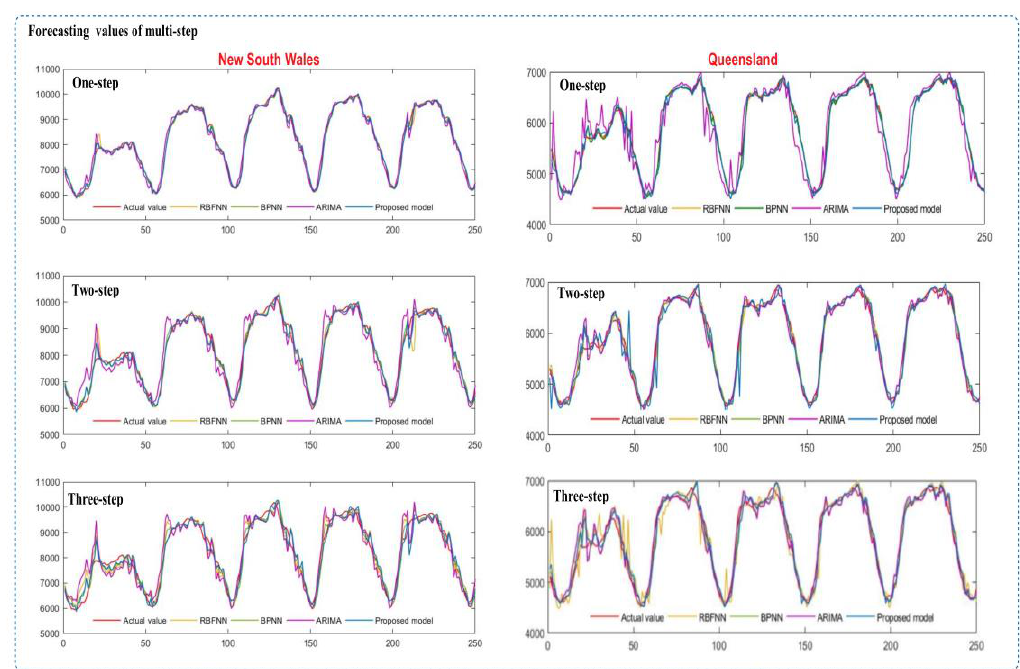
Figure 3. Multi-step forecasting results of di ff erent models using data from New South Wales and Queensland.